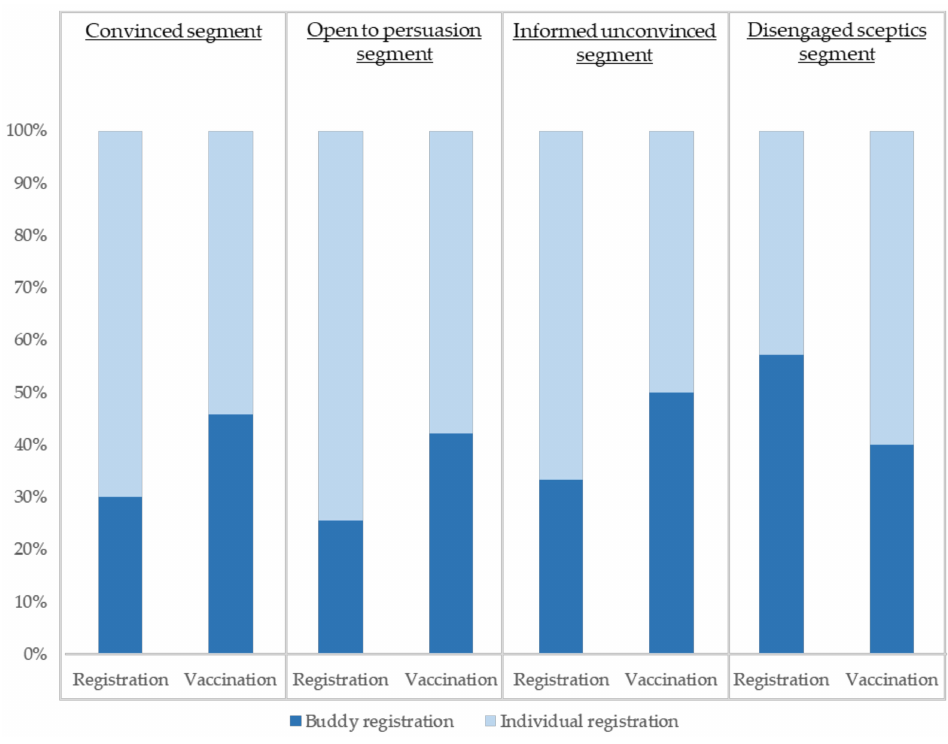
Figure 6. Percentage of registration and vaccination obtained through individual vs. buddy offers by student